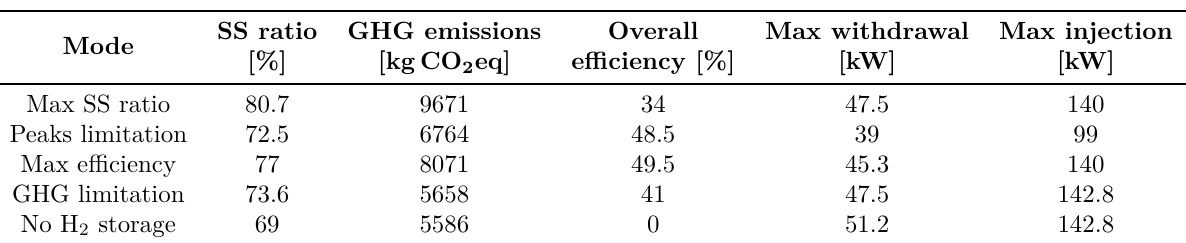
Table 1. Results from the different program